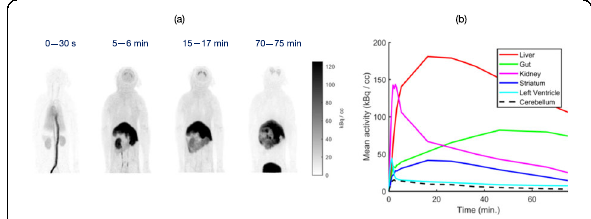
Fig. 1 (abstract A23). ( a ) Maximum intensity projection images at various time-points. ( b ) Time activity curves up to 75 minutes post-injection, representing approximately 4 half-lives of 11 C